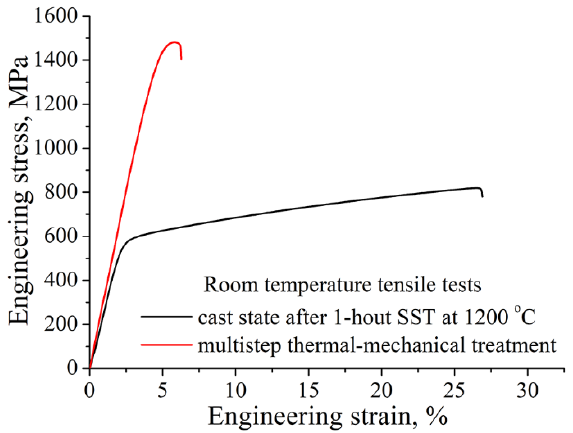
Figure 3. Engineering stress vs. engineering strain diagrams for V-HNS after solid-solution treatment and multistep thermal-mechanical treatment.